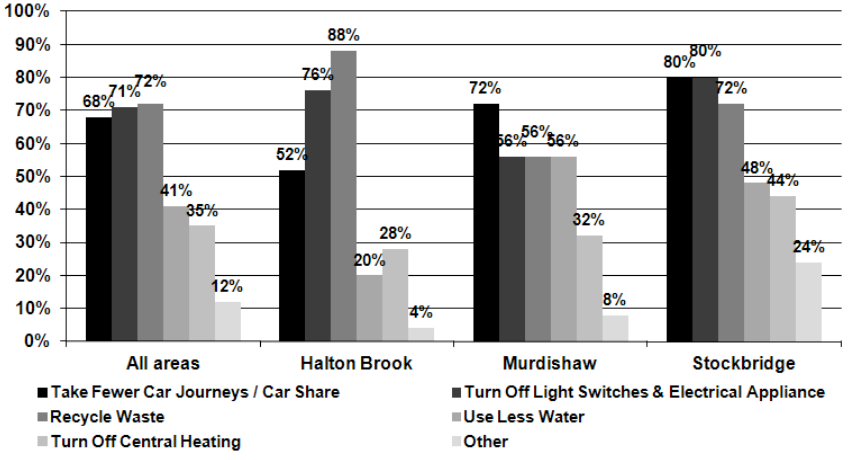
Figure 11. Environment. How residents’ contribute to reducing emissions and saving the